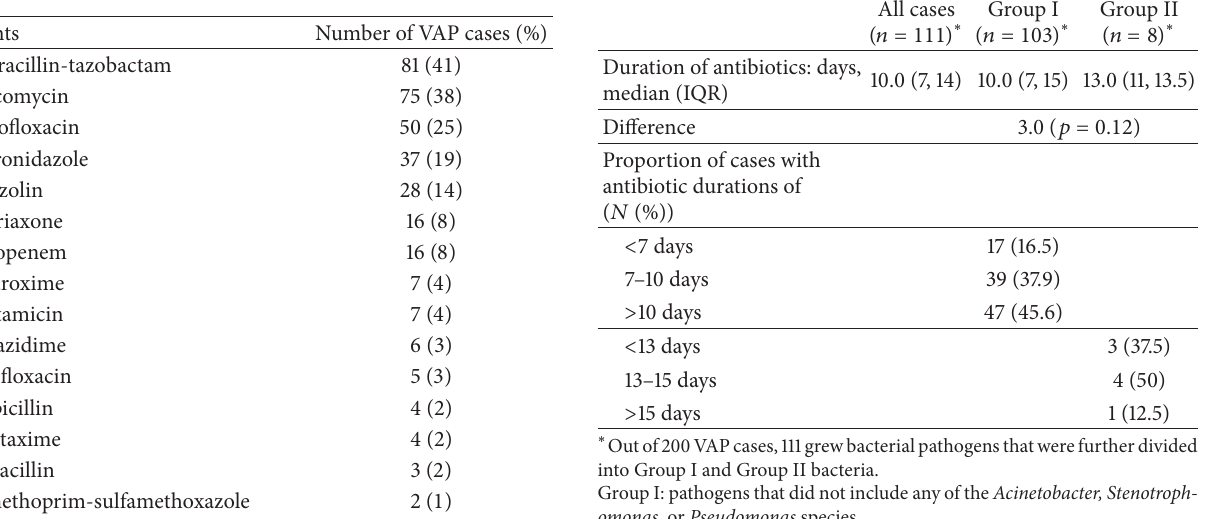
Table 3: Empiric antibiotics initiated (total number of VAP cases = 200).